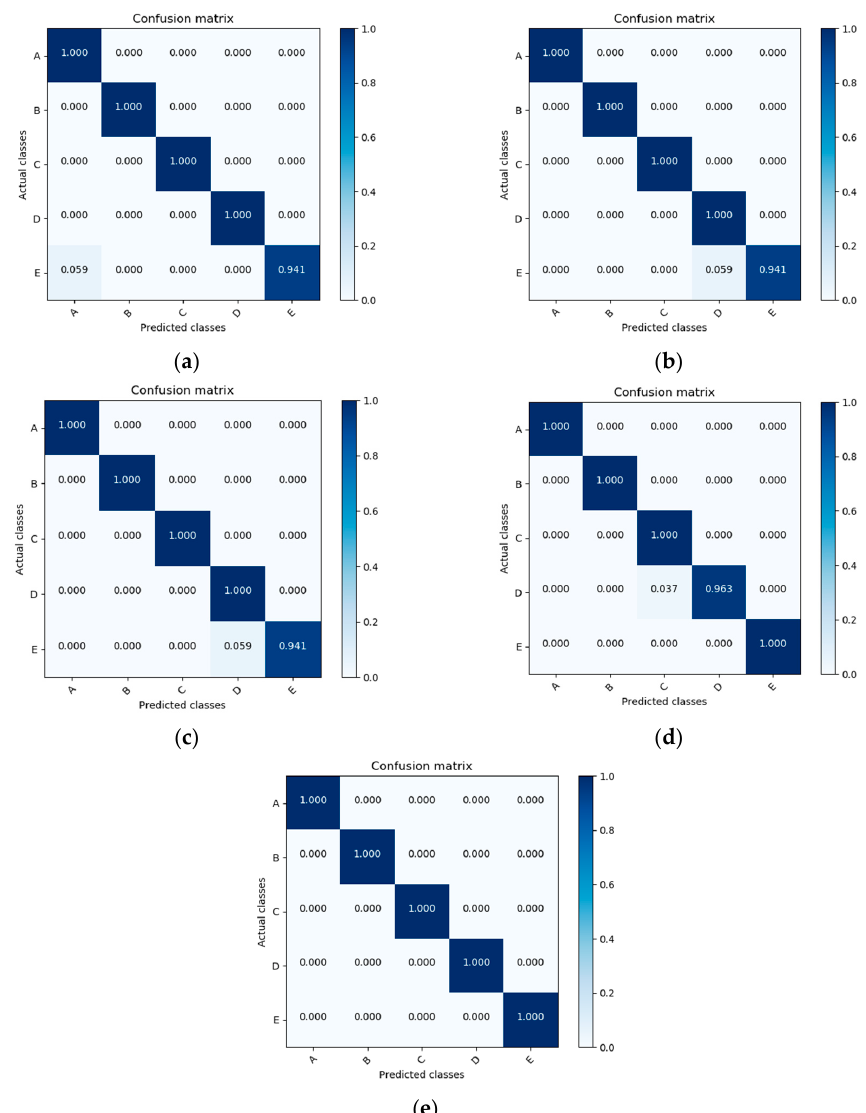
Figure 8. Fold cross validation results expressed in confusion matrixes: ( a ) Confusion matrix showing results of test on fold 1; ( b ) Confusion matrix showing results of test on fold 2; ( c ) Confusion matrix showing results of test of fold 3; ( d ) Confusion matrix showing results of test on fold 4; ( e ) Confusion matrix showing results of test on fold 5.